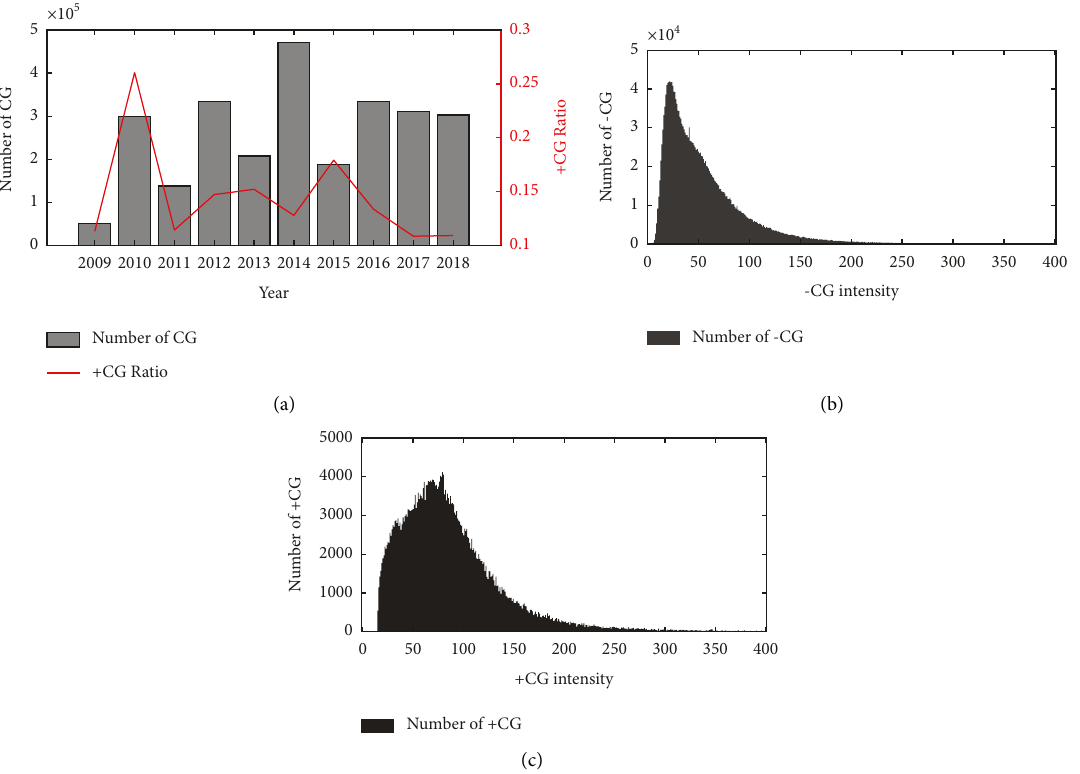
Figure 2: (a) Total number of CG lightning flashes from 2009 to 2018. The curve indicates the proportion of +CG lightning. (b, c) Intensity probability distributions of − CG and +CG lightning,